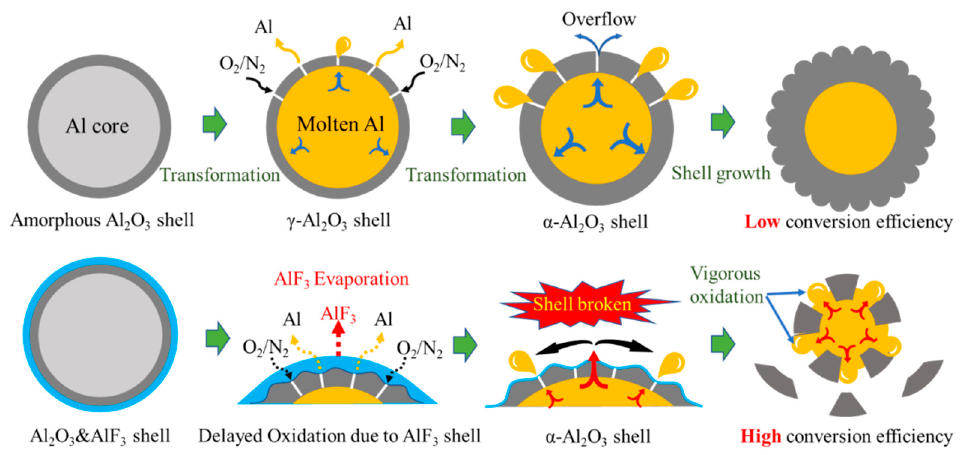
Figure 12. The diagram of potential oxidation promotion mechanism. The dark gray parts refer to Al 2 O 3 . The yellow parts refer to molten Al. The light blue parts refer to aluminum fluoride.